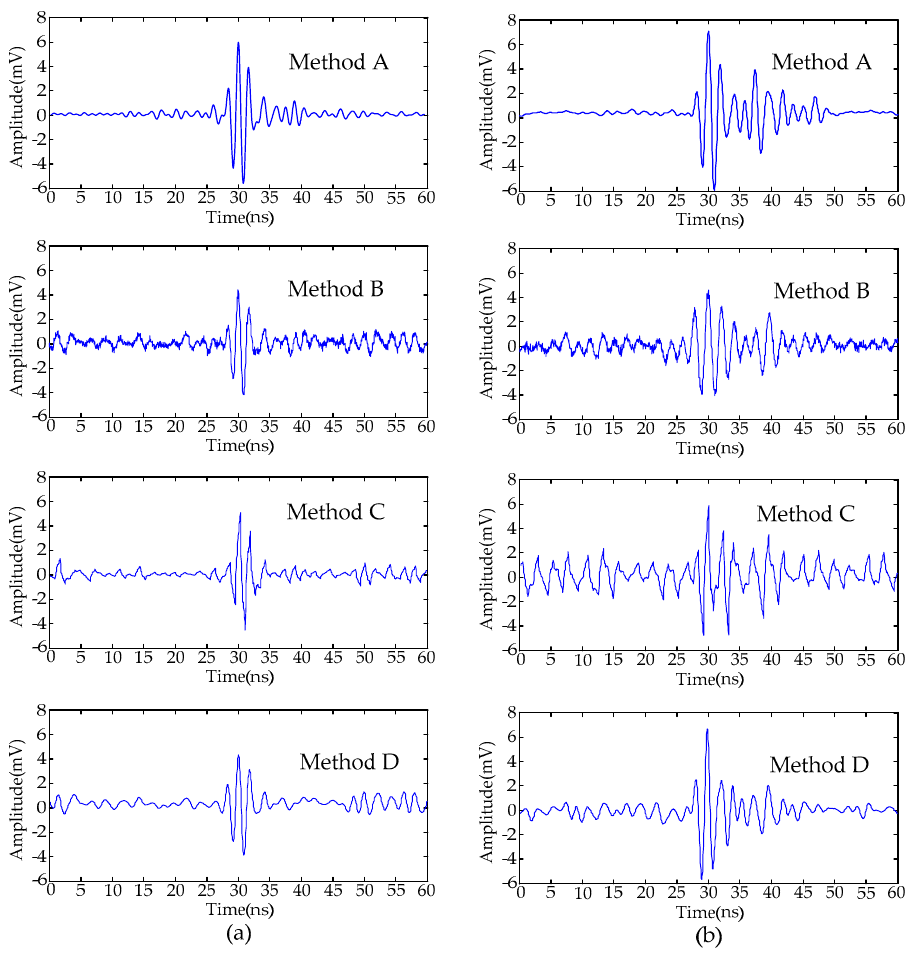
Figure 16. De-noised PD signals in field detection using each method: ( a ) signal #1; ( b ) signal #2.